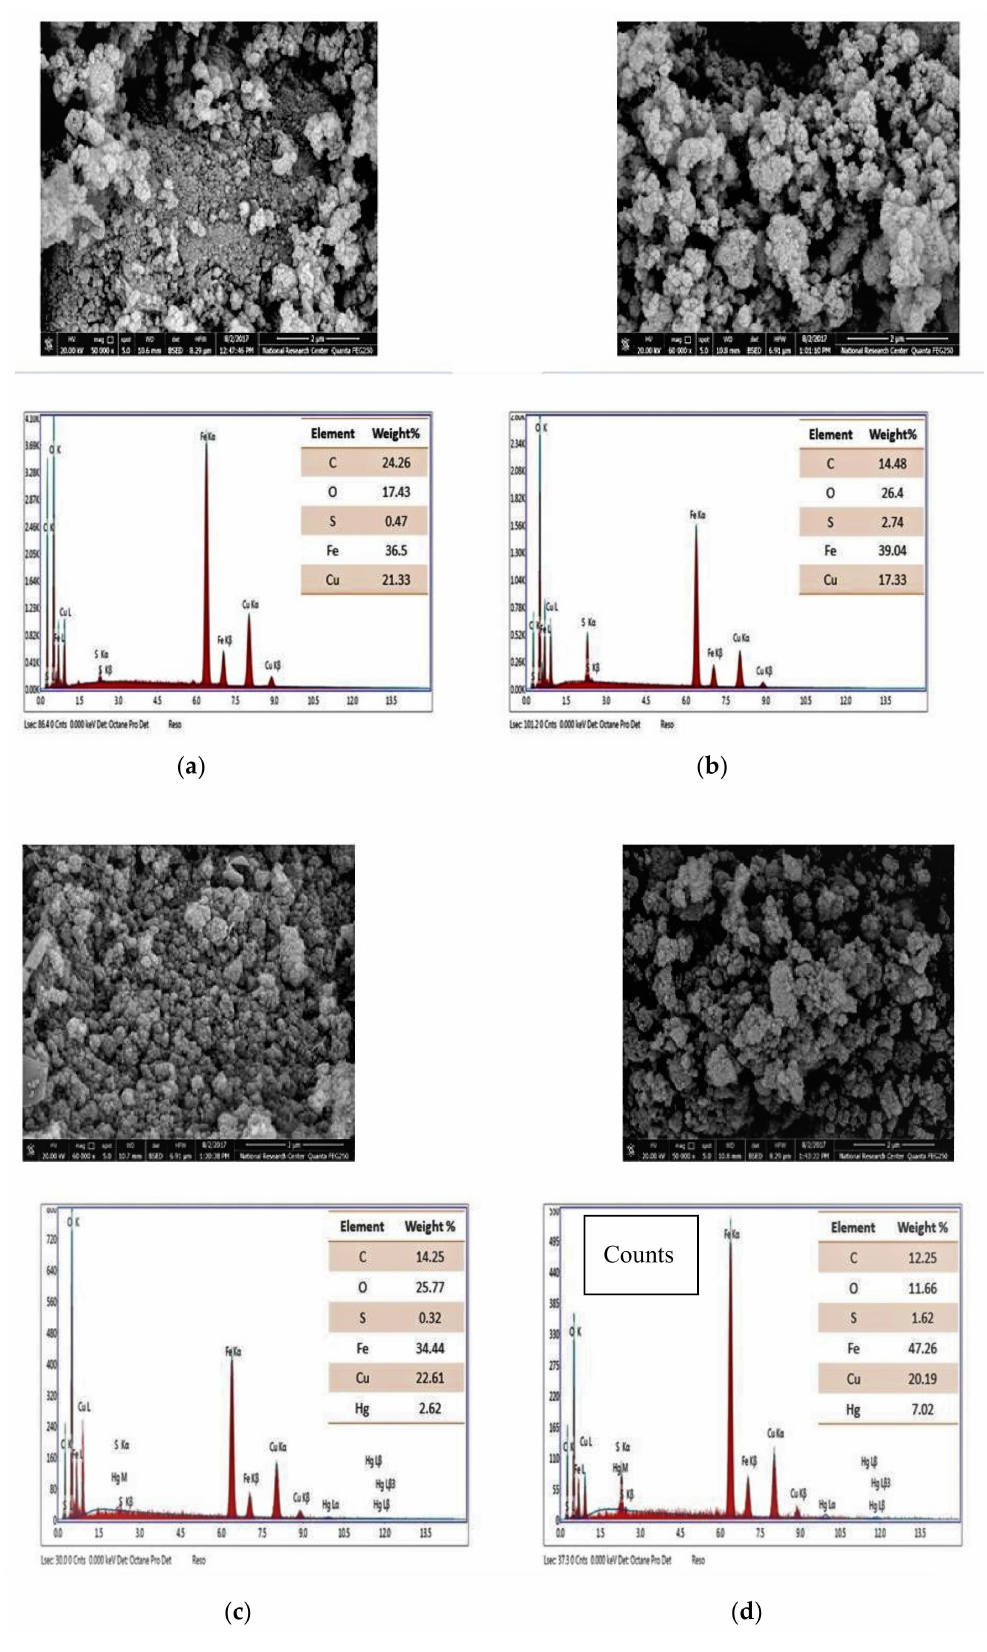
Figure 2. Field emission scanning electron microscopy (FESEM) before adsorption for CuFe 2 O 4 ( a ) and ( b ) CuFe 2 O 4 @Polythiophene composite) and after Hg 2 + adsorption (CuFe 2 O 4 ( c ) and ( d ) CuFe 2 O 4 @Polythiophene